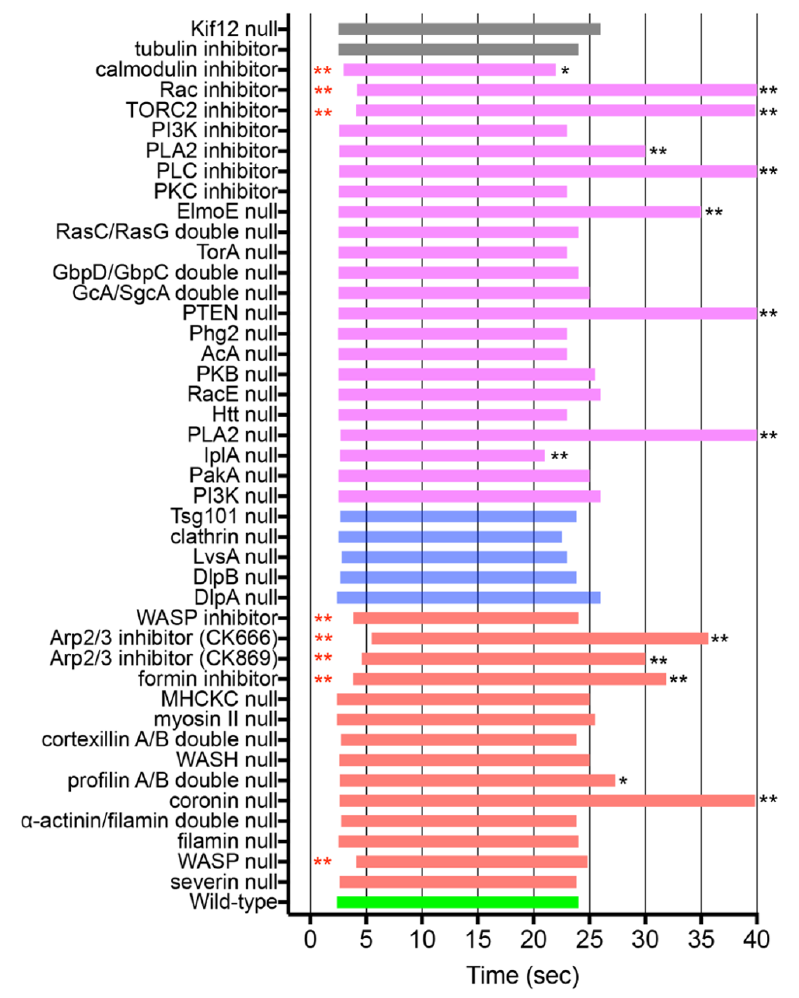
Figure 4. Durations of wound-induced actin dynamics in null cells or wild-type cells in the presence of inhibitors. Durations of wound-induced actin dynamics in null cells or wild-type cells in the presence of inhibitors: actin-related (red), signal-related (purple), membrane dynamics-related (blue), and microtubule-related (gray) proteins. Actual time courses of the fluorescence intensities are shown in Supplementary Figures S3 and S4. Red asterisks indicate the cases showing significantly retarded initiation time compared with the control, and black asterisks indicate the cases showing significantly retarded termination time. * p ≤ 0.001, ** p ≤ 0.0001 ( n ≥ 25 each).